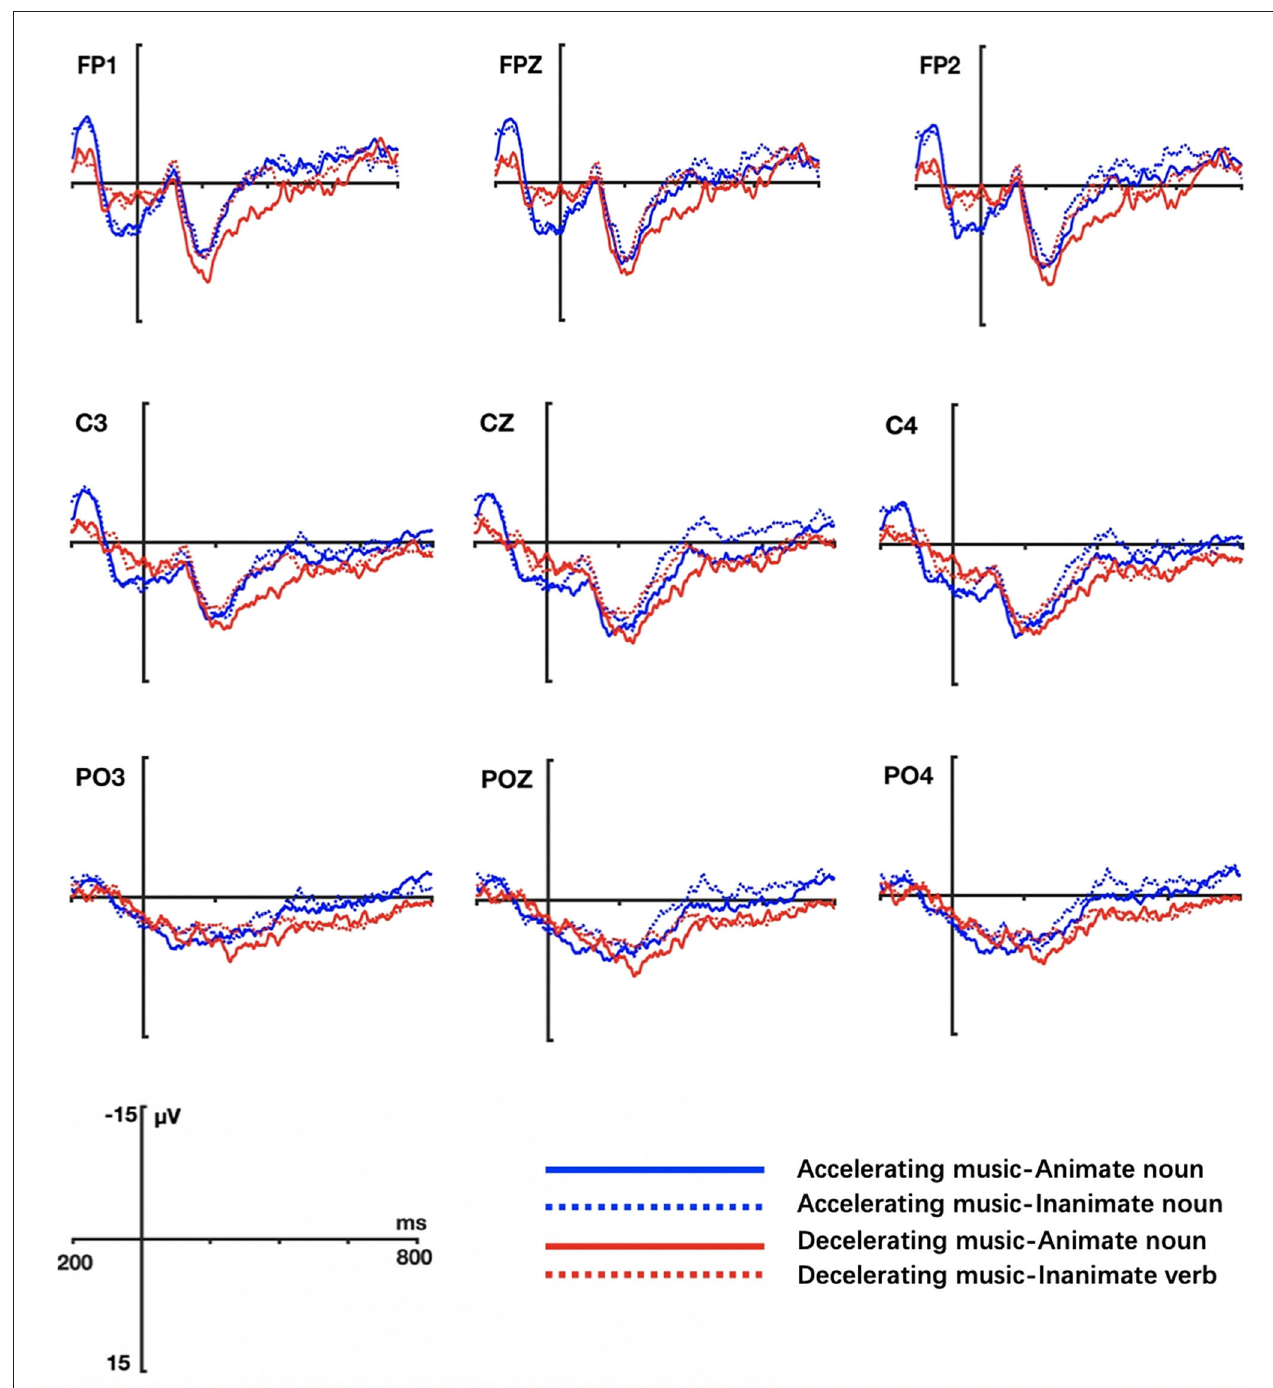
FIGURE 6 | Grand ERP averages elicited by animate and inanimate nouns in tempo-with-change music priming conditions (Task 3).